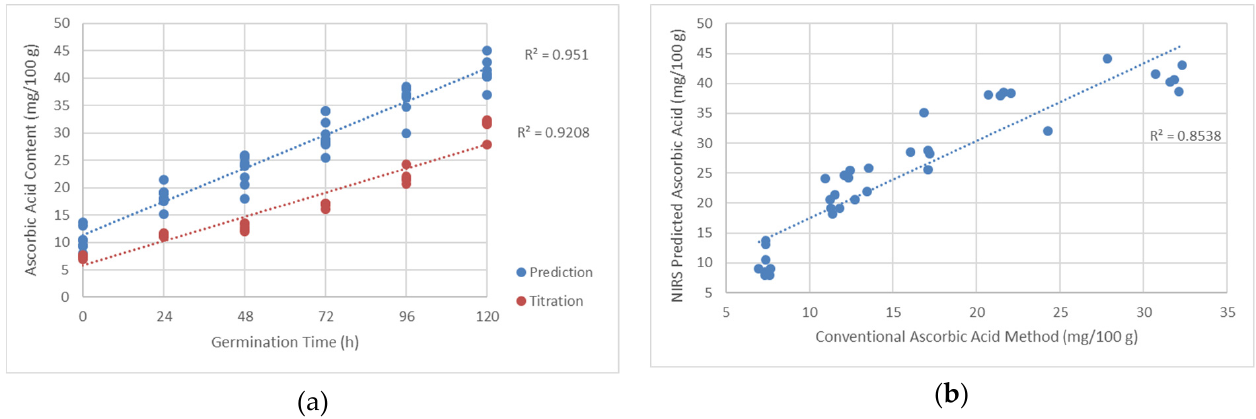
Figure 8. Ascorbic acid determination comparison between predicted titration and NIR spectroscopy: ( a ) Ascorbic acid content plot comparison for NIR spectroscopy predicted and titration values, and ( b ) ascorbic acid content plot of NIR spectroscopy predicted against titration values.